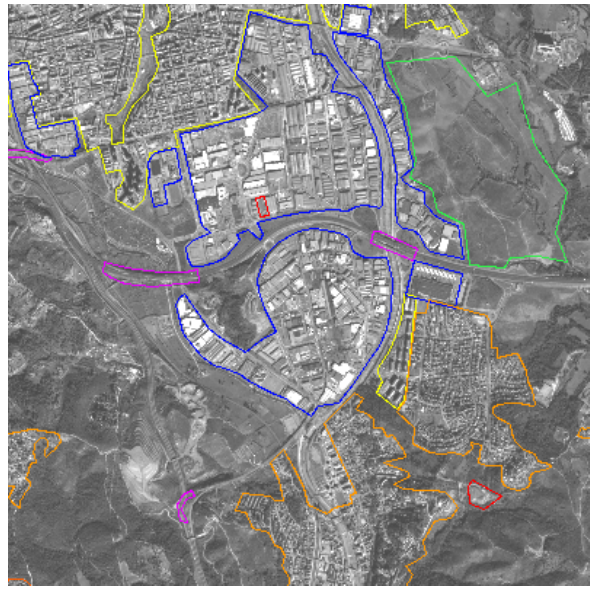
Figure 2: Different subareas in the Terrassa area. Yellow: City; Blue: Industrial; Purple: Bridges; Orange: Residential; Green: Fields, Red: Changes .